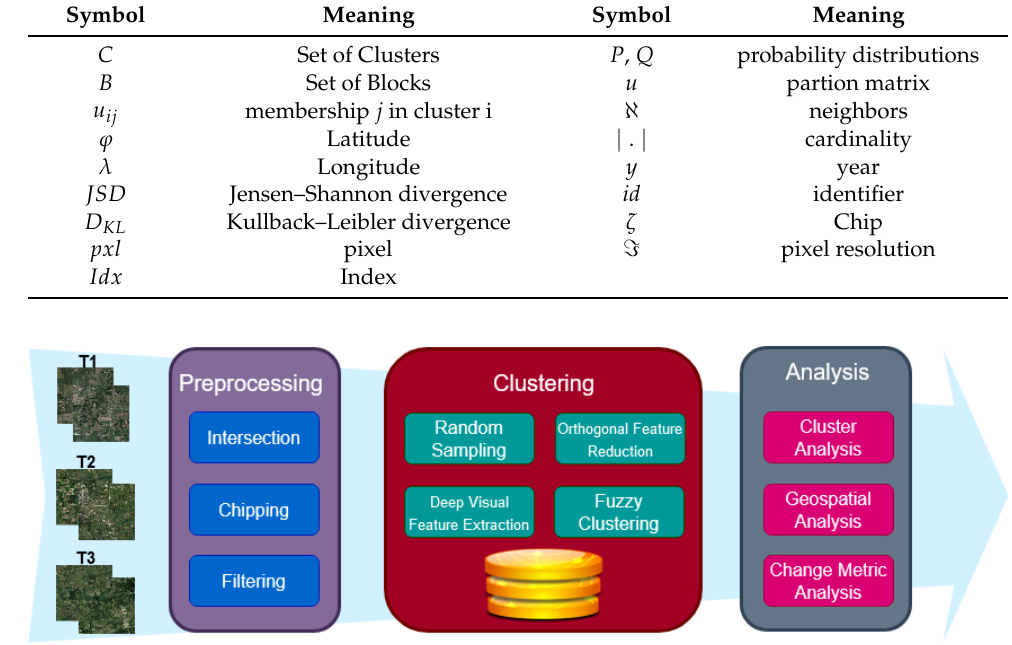
Figure 1. General workflow of the system divided into three main stages: preprocessing, clustering, and analysis. Each stage compromises of several